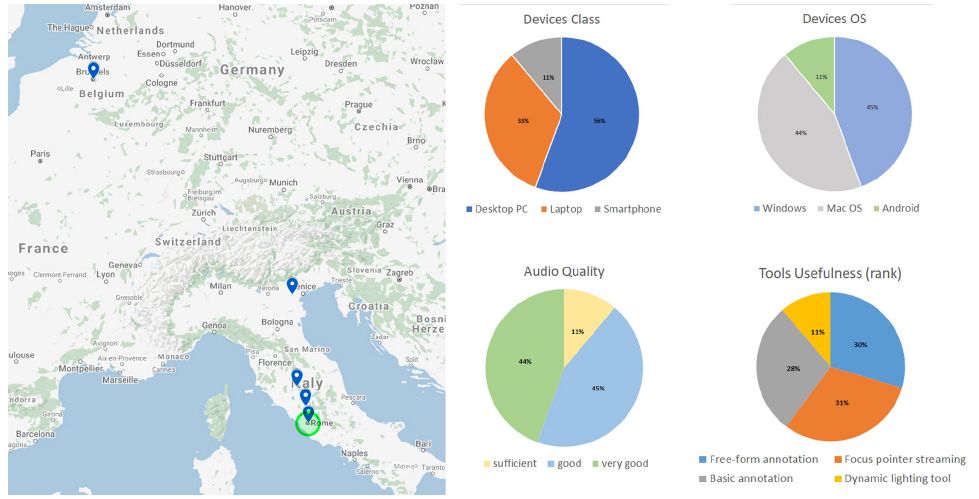
Figure 22. Nora collaborative experiment